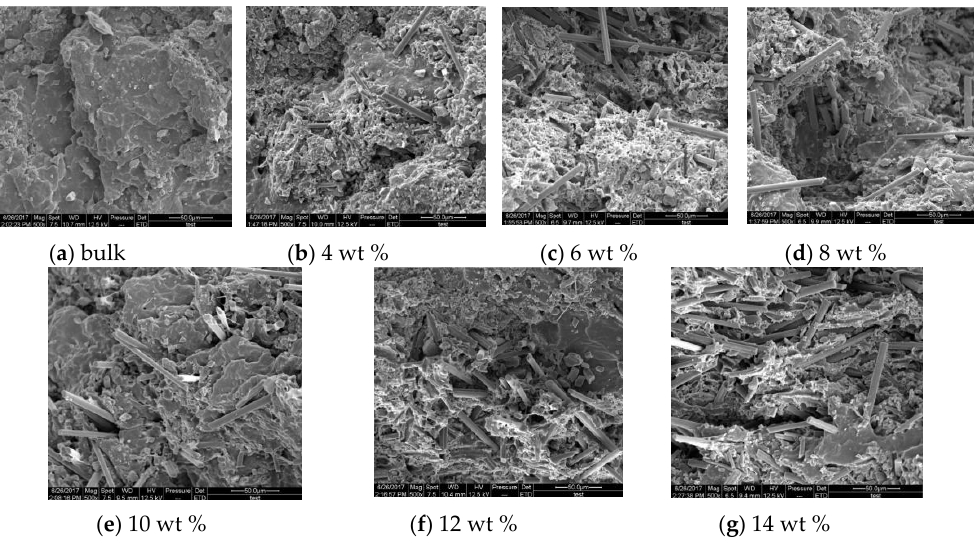
Figure 8. Scanning electron microscopy ( SEM ) images of cross-sections of SMPC specimens with different chopped carbon fiber contents of ( a ) bulk, ( b ) 4 wt %, ( c ) 6 wt %, ( d ) 8 wt %, ( e ) 10 wt %, ( f ) 12 wt % and ( g ) 14 wt % after static tensile test at a temperature of 299 K.